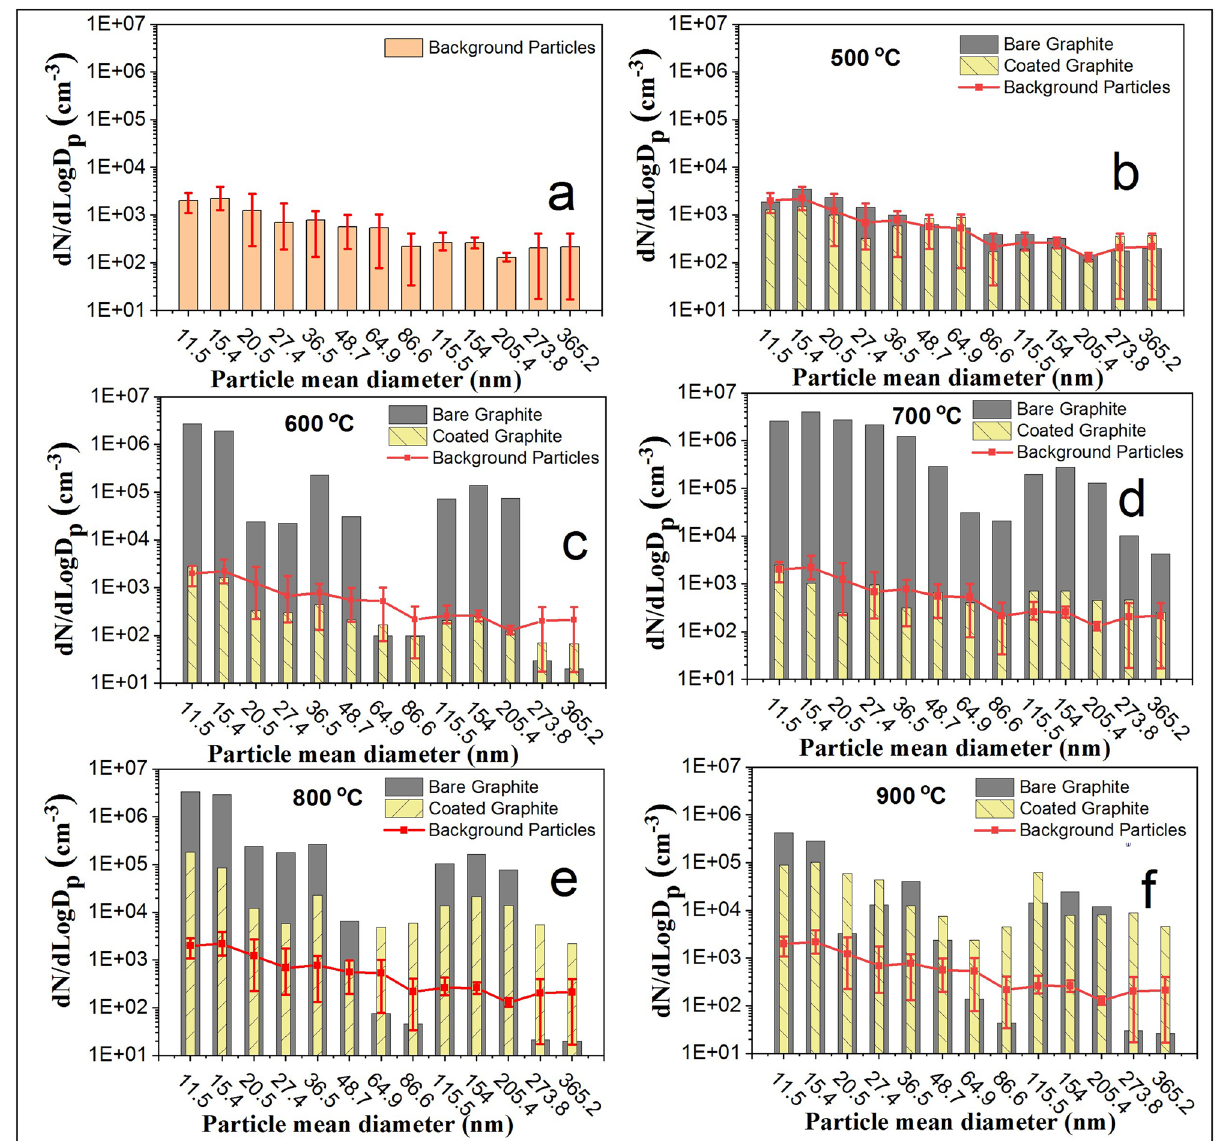
Figure 4. Number size distribution for generated particles from bare and coated graphite